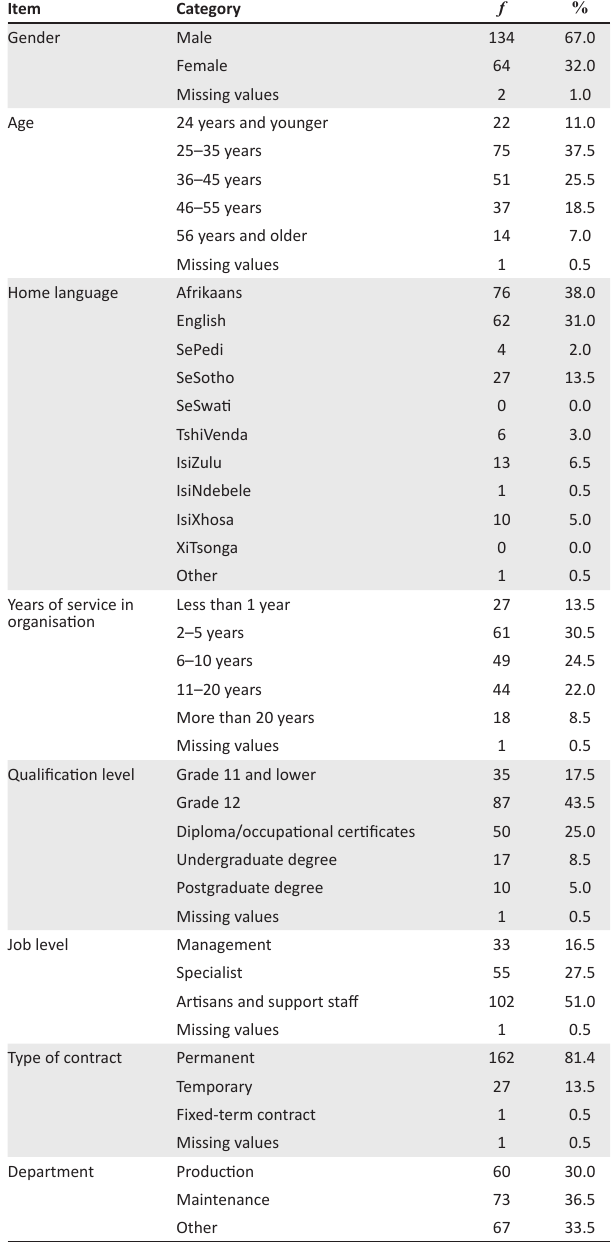
TABLE 1: Characteristics of the